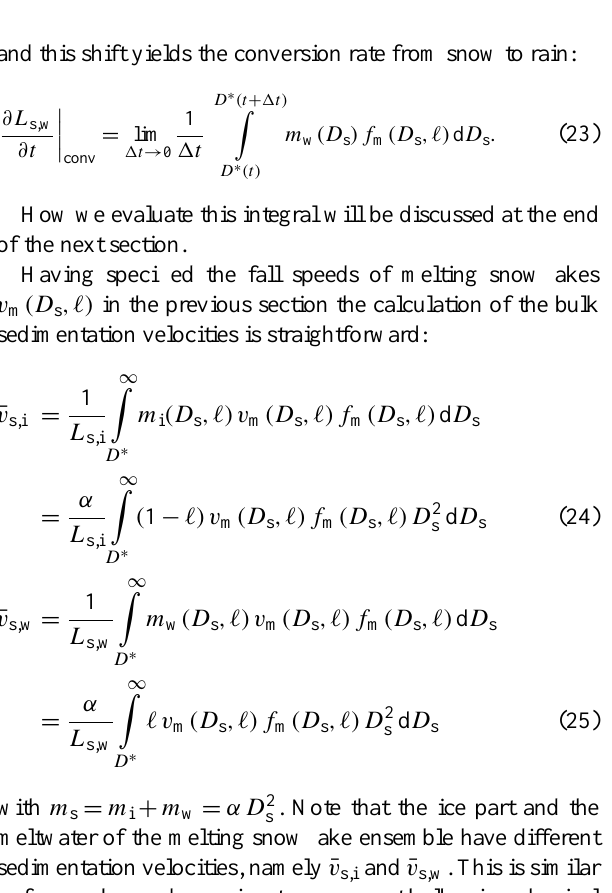
Fig. 2. Size distributions obtained with the new melting parameterization using a bulk liquid water fraction of 0.2 and a snow mixing ratio of 3gkg − 1 . The two values of D ∗ (indicated by the vertical dashed lines) illustrate a shift of the critical diameter due to the conversion from snow to rain.